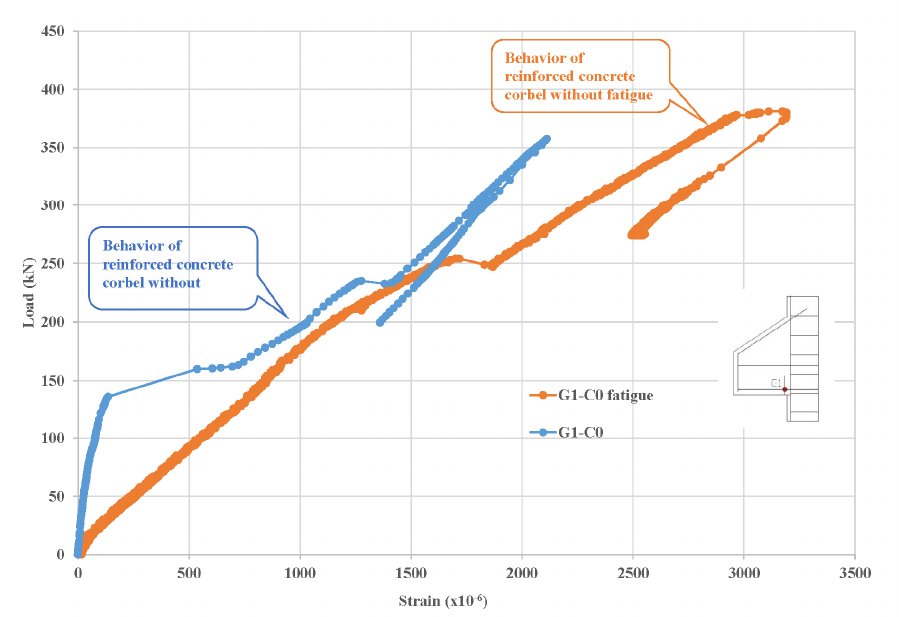
Figure 4: Effect of fatigue on reinforced concrete corbels under static tests.